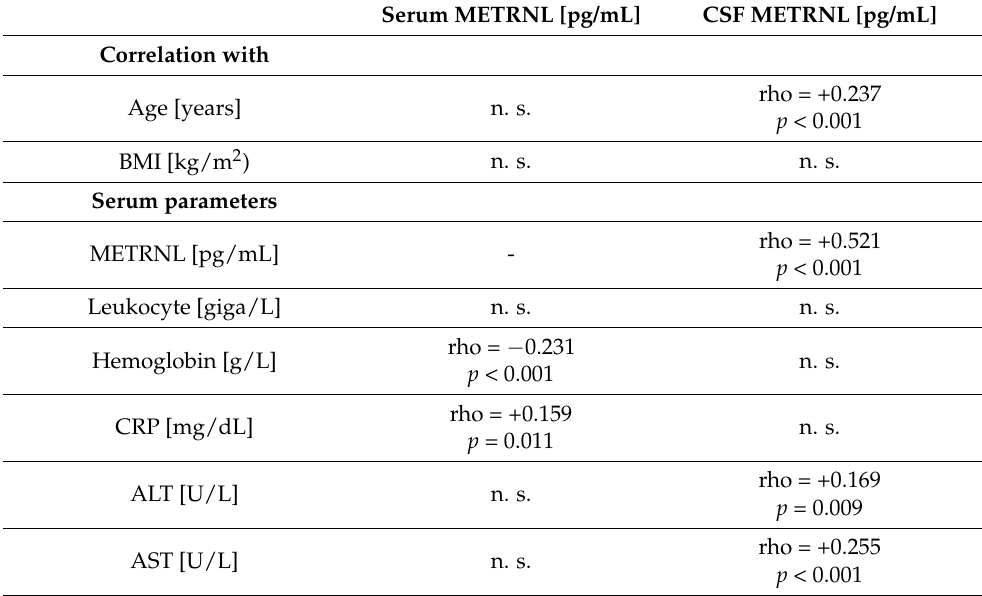
Table 2. Correlation analysis by Spearman rho test of serum or CSF METRNL concentrations with stan- dard serum and CSF parameters. ALT, alanine-aminotransferase; AST, aspartate-aminotransferase; BMI, body mass index; CSF, cerebrospinal fluid; HDL, high density lipoprotein; LDL, low density lipoprotein; METRNL, Meteorin-like protein; n. s., not significant; Ig,